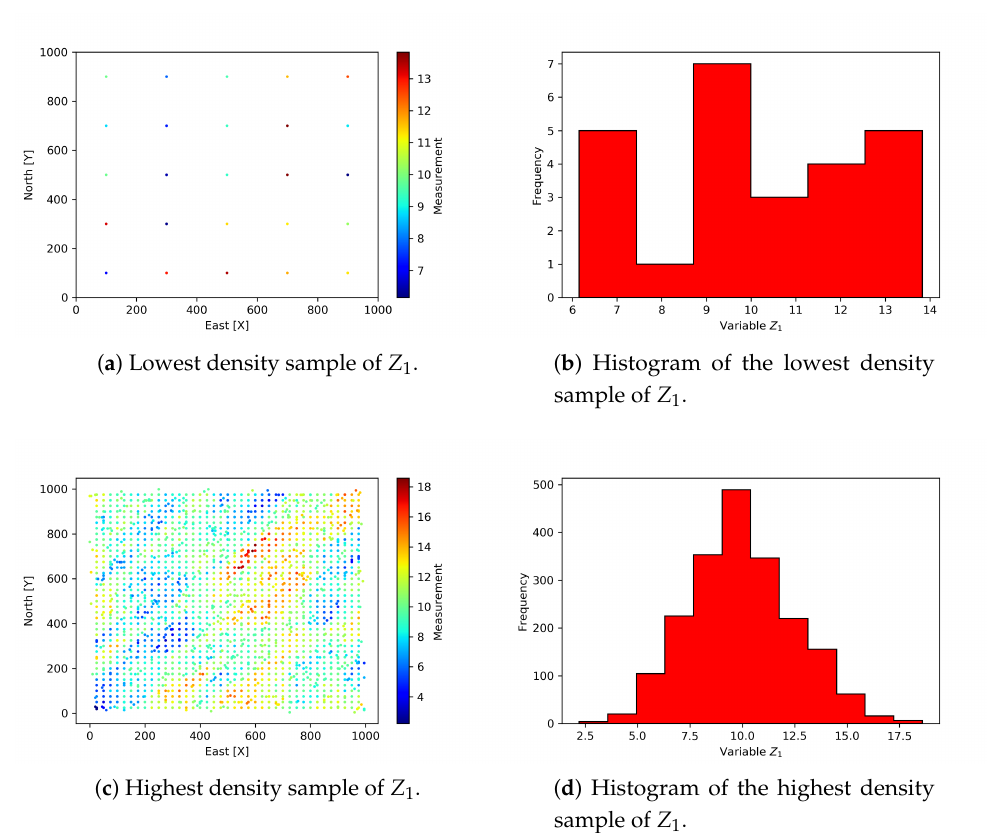
Figure 6. Maps and histogram of samples of Z 1 , limit